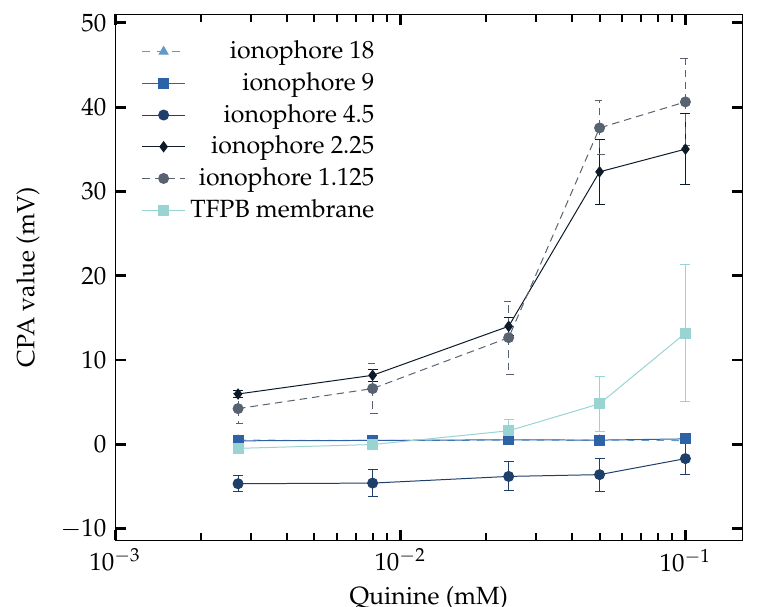
Figure 5. CPA responses of NaISE of different Na + ionophore concentrations to NaCl (70 mM) + qui- nine